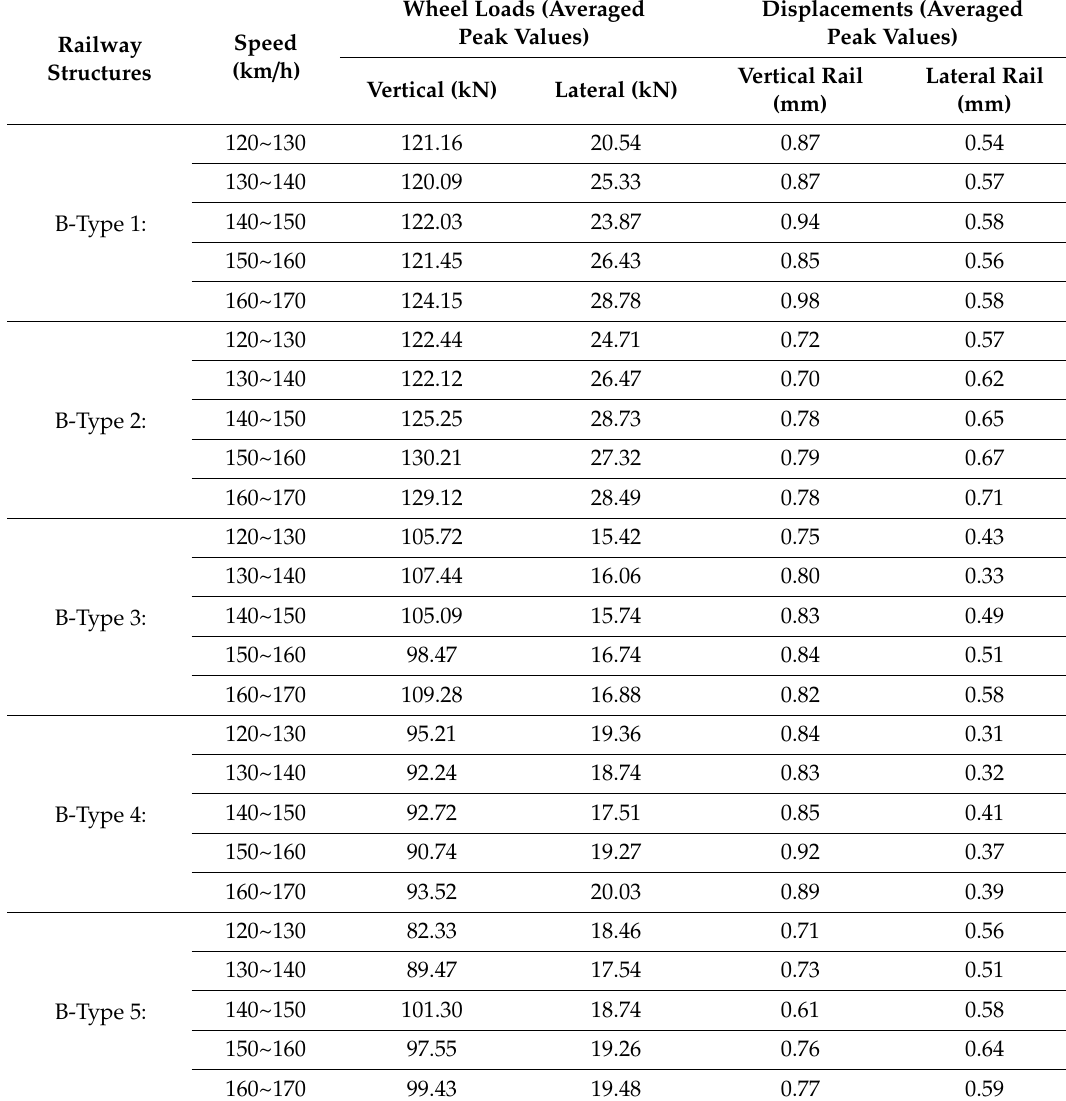
Table 7. Average values of maximum dynamic response by passing train for ballasted track structures.